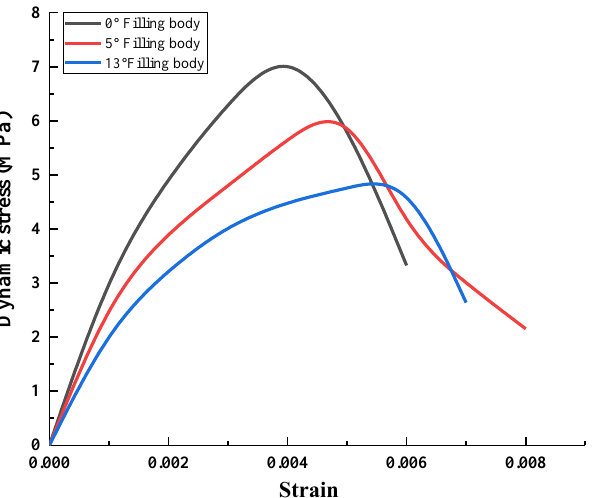
Figure 19. Stress – strain curves from the numerical simulation of the filling body at different an- Figure 19. Stress–strain curves from the numerical simulation of the filling body at different gles.